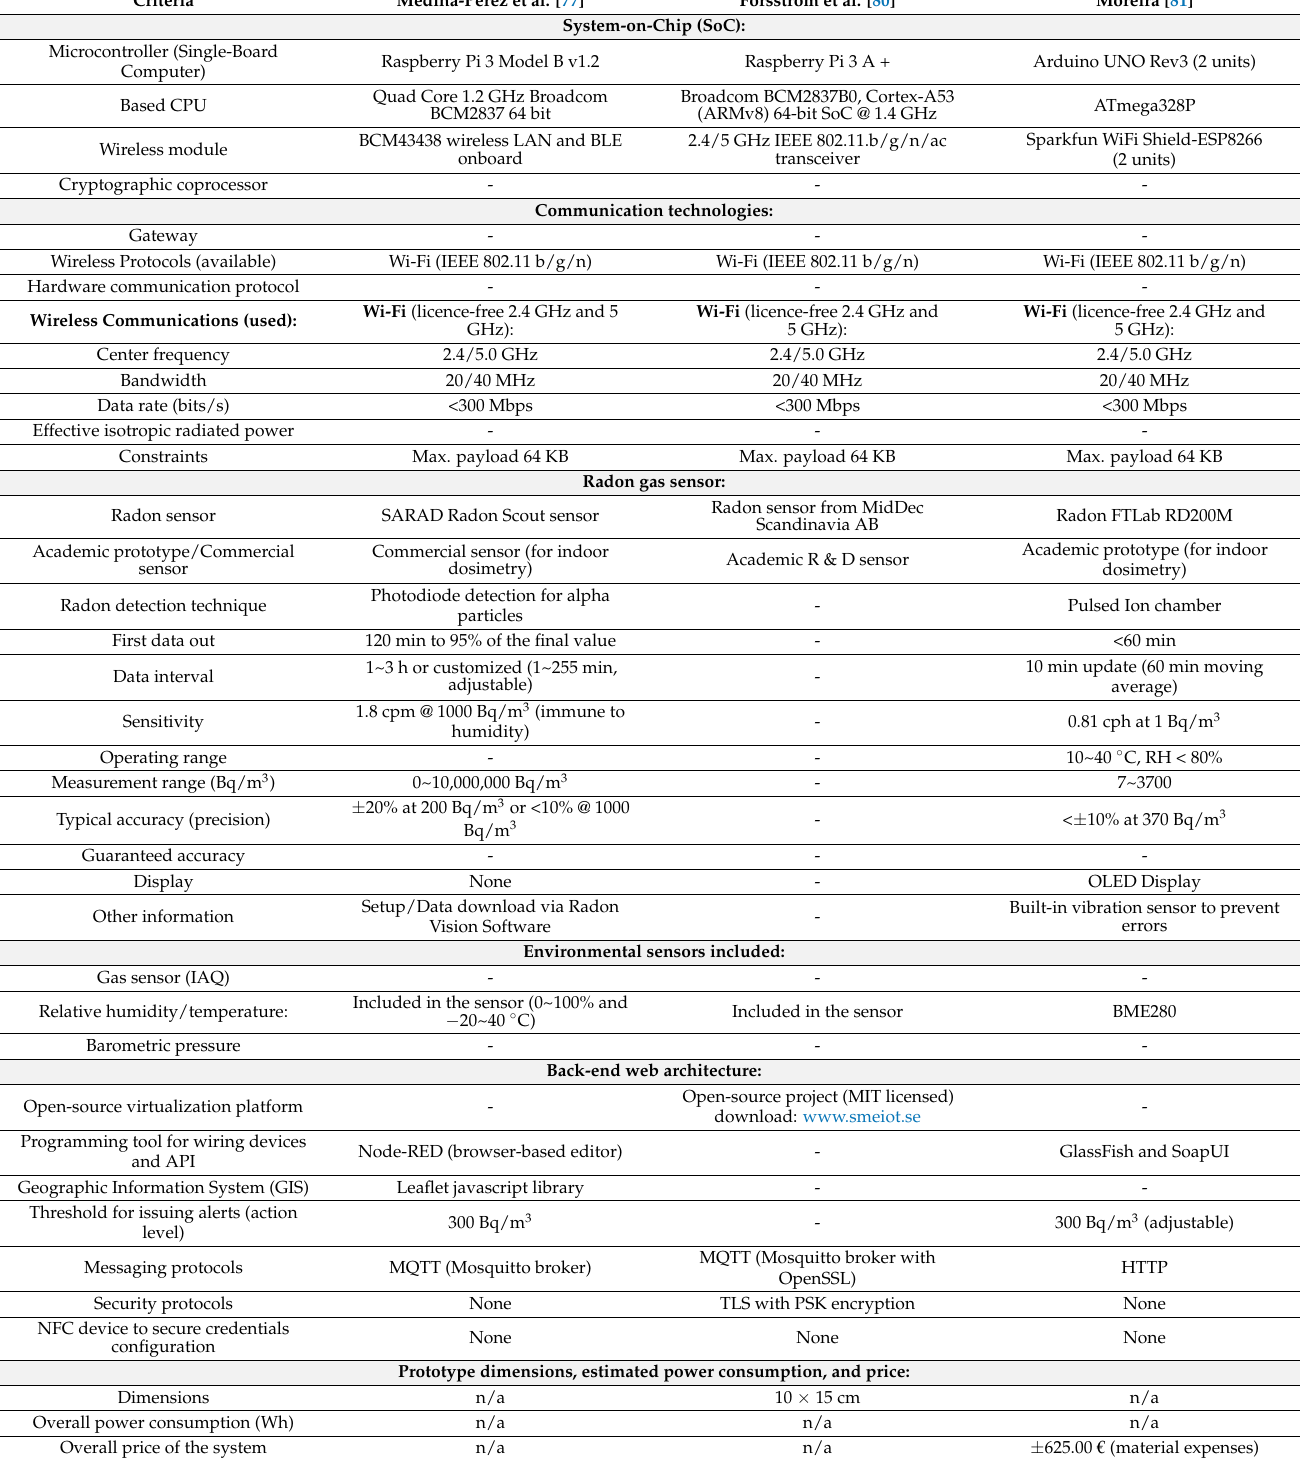
Table 6. Comparative study for radon monitoring